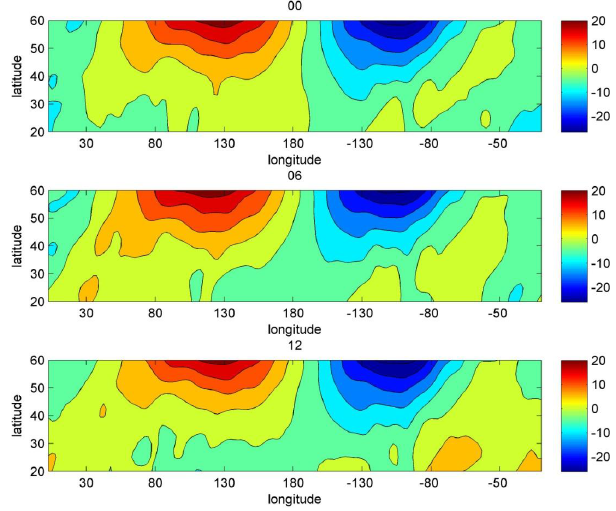
Figure 4. Plot of average meridional wind speed (ms − 1 ) compo- nent at 10hPa for January 1958–2012 at 20–60 ◦ N, 180 ◦ E–180 ◦ W. Top panel: 00:00UTC; middle: 06:00UTC; bottom: 12:00UTC. Positive values (poleward wind): red; negative values (equatorward wind): blue. NCEP/NCAR reanalysis only.